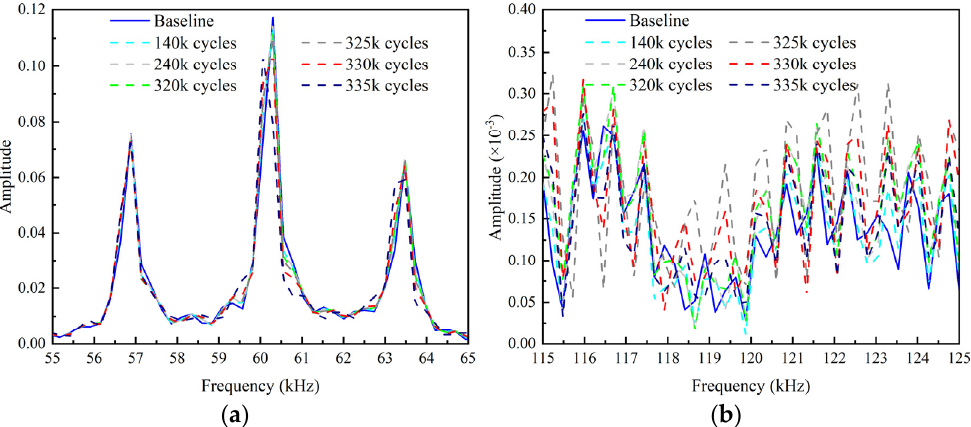
Figure 31. Frequency spectrums after various loading cycles corresponding to 10-cycle excitation. ( a ) Fundamental frequency spectrums around central frequency; ( b ) Second-order frequency spec- trums around double of central frequency.